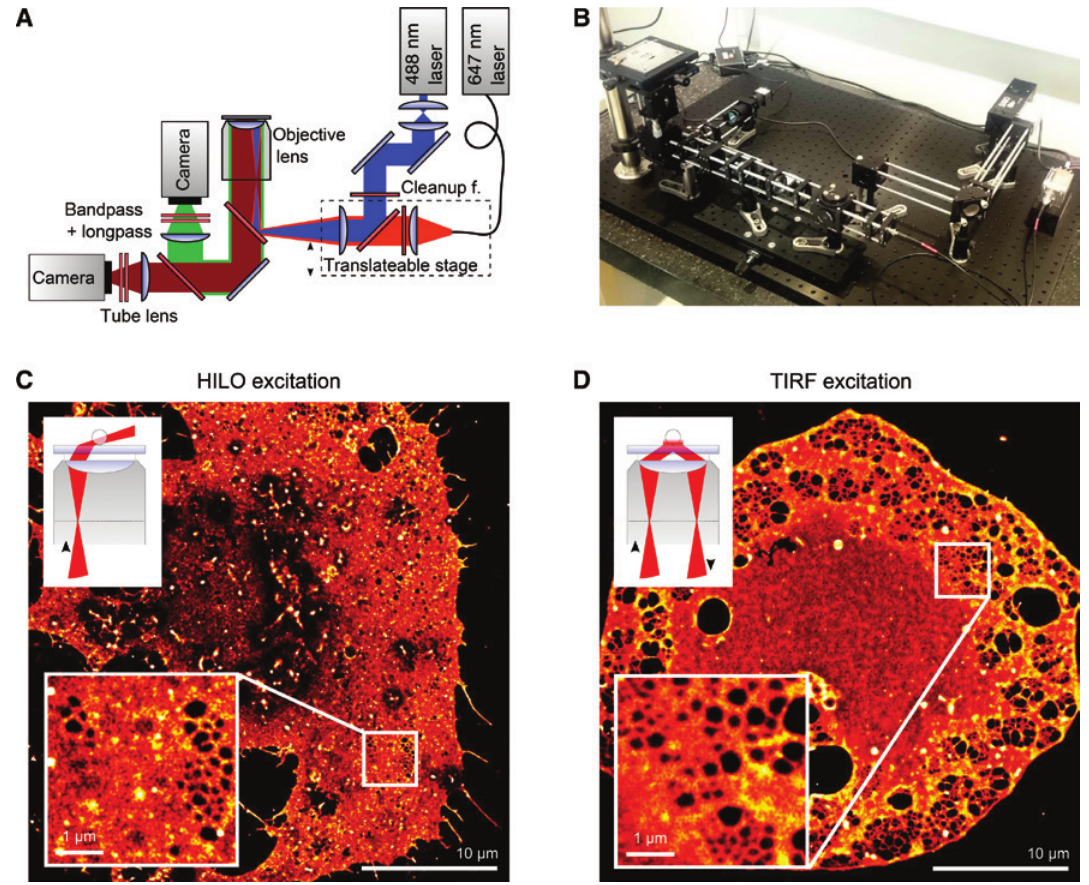
Figure 1: The cost-efficient dual-color dSTORM